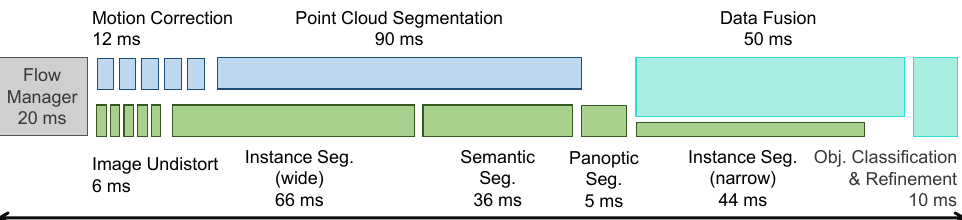
Figure 15. Execution flow and timing diagram with average processing times: the top blue 3D processing chain running on the CPU in parallel with the one for 2D data, running on the